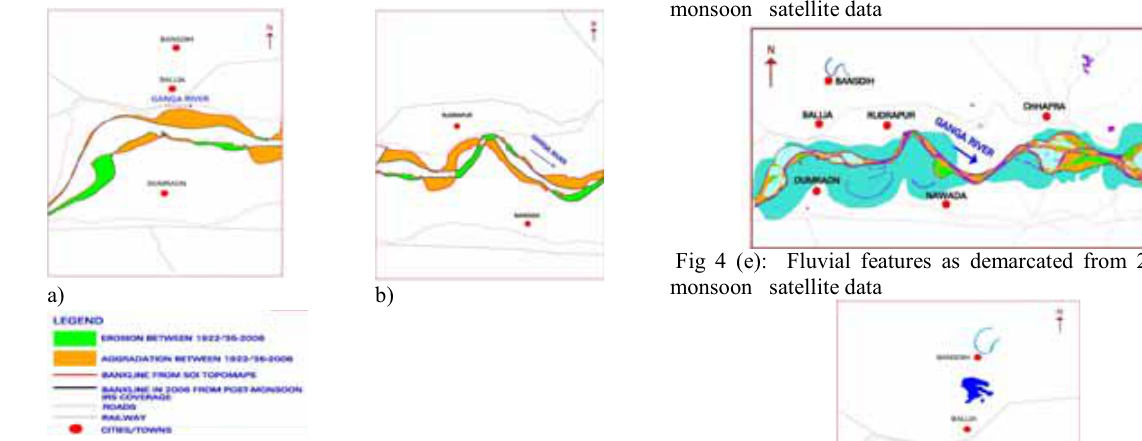
Fig 3: Erosion and deposition along both the banks of the